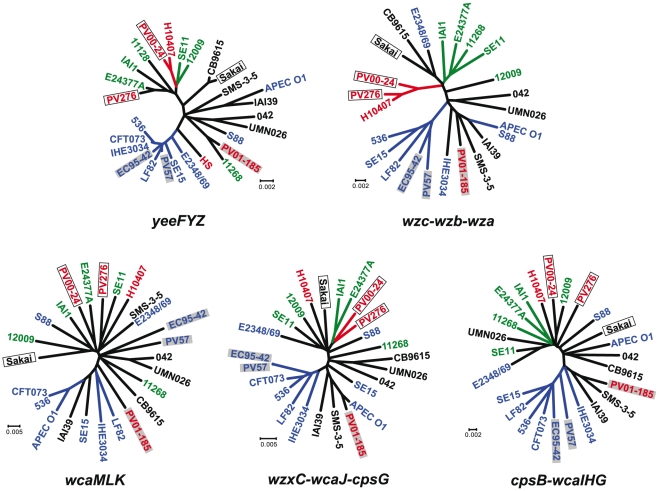
Phylogenetic analyses of the O157-antigen gene cluster-flanking regions.The phylogenetic trees were constructed based on concatenated sequences of yeeFYZ, wcaMLK, wzxC-wcaJ-cpsG, cpsB-wcaIHG and wzc-wzb-wza by neighbor-joining method using Tamura-Nei model. O157 strains carrying “Sakai-type rfbE” and “PV01-185-type rfbE” are indicated by clear and gray boxes, respectively. Colors (red, green and blue) indicate their E. coli phylogroups (A, B1 and B2), respectively.